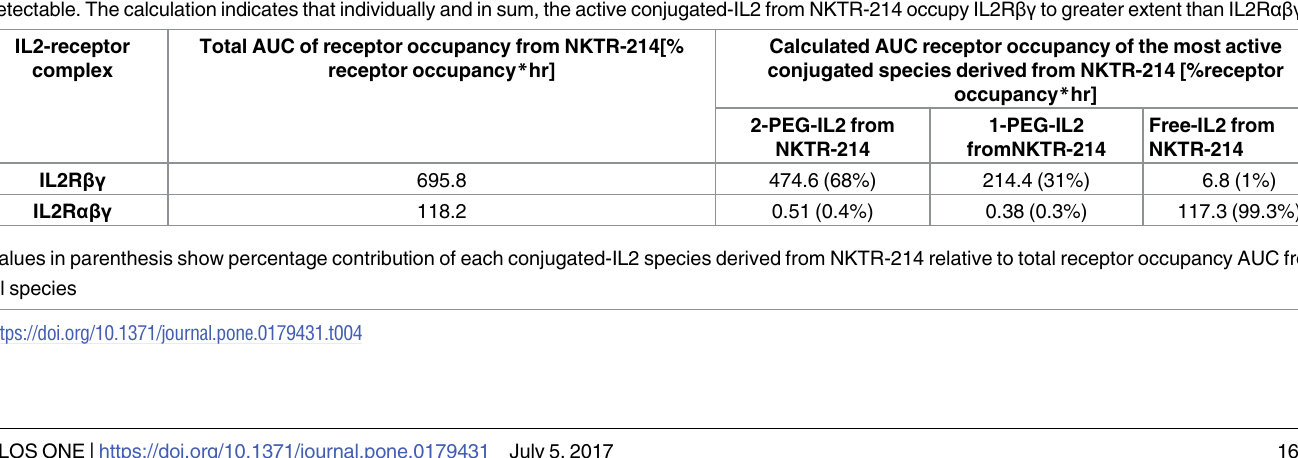
Table 4. Model-simulated values of receptoroccupancy for the conjugated-IL2 species and free-IL2 derived from NKTR-214after a single dose administration. 1-PEG-IL2 and 2-PEG-IL2 are present at significantly higherlevels in plasma than IL2. Experimentally, free-IL2 from NKTR-214 is not detectable. The calculationindicatesthat individually and in sum, the active conjugated-IL2 from NKTR-214 occupy IL2R βγ to greater extent than IL2R αβγ . IL2-receptor complex